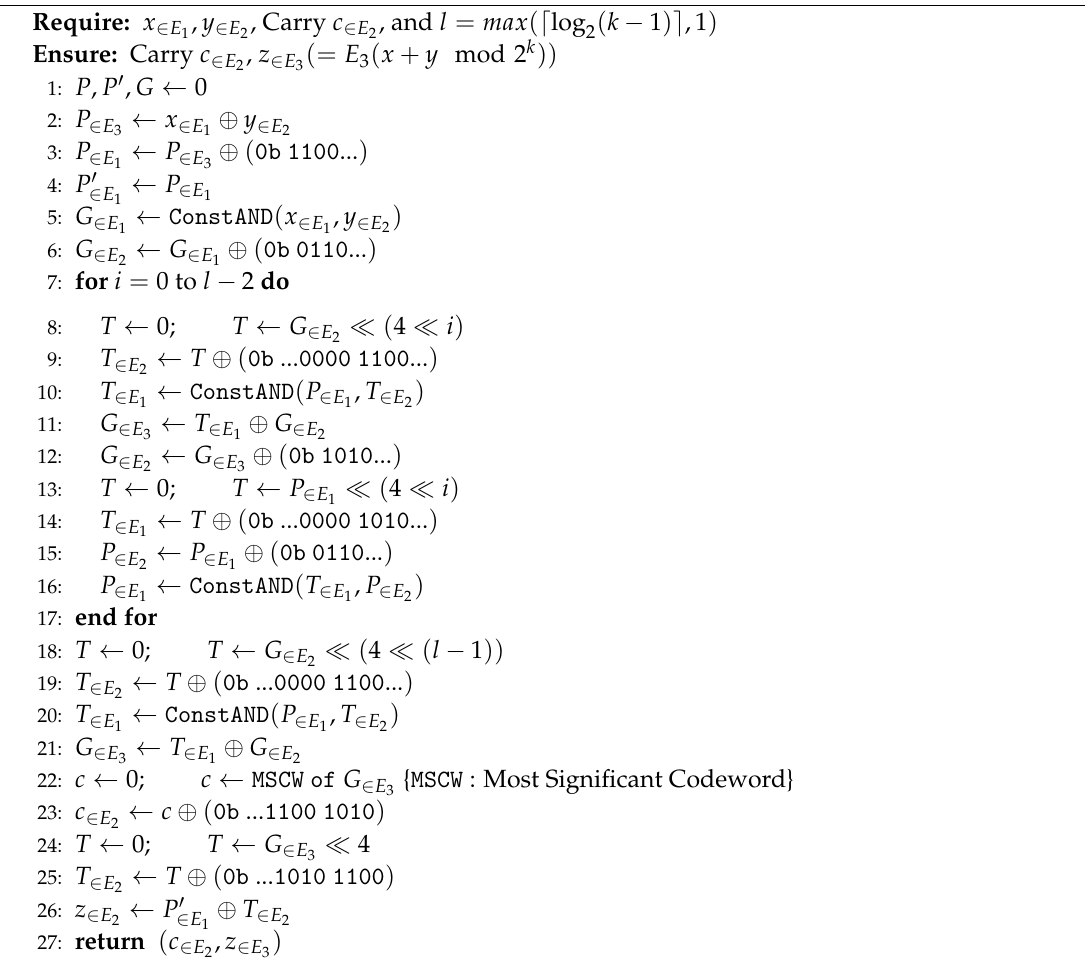
Algorithm A2: BKSAdder Coron , Coron’s KS Adder Applied to Power-balancing Methods